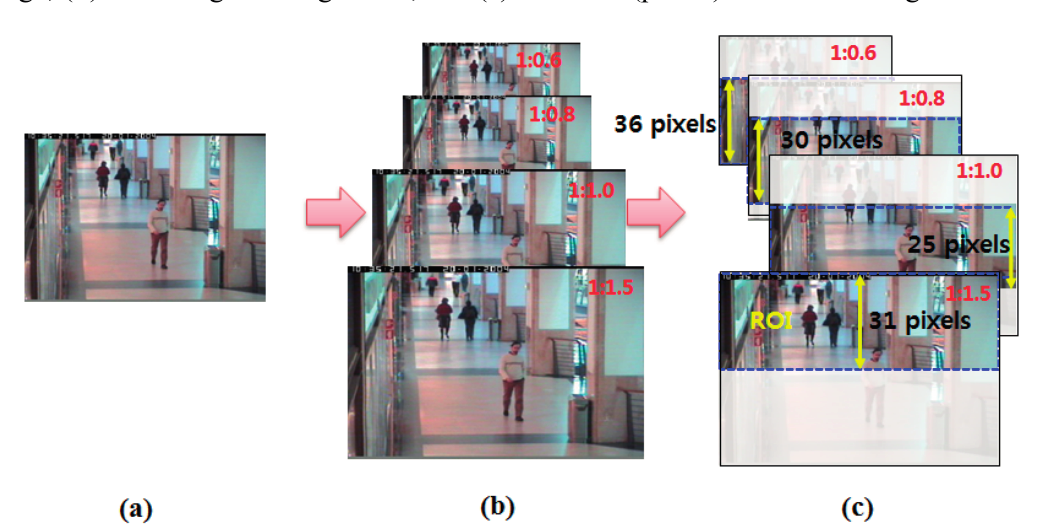
Figure 4. The selected image-scaling levels and ROI size per scaling level: ( a ) original image; ( b ) four image-scaling levels; and ( c ) ROI size (pixels) for each scaling